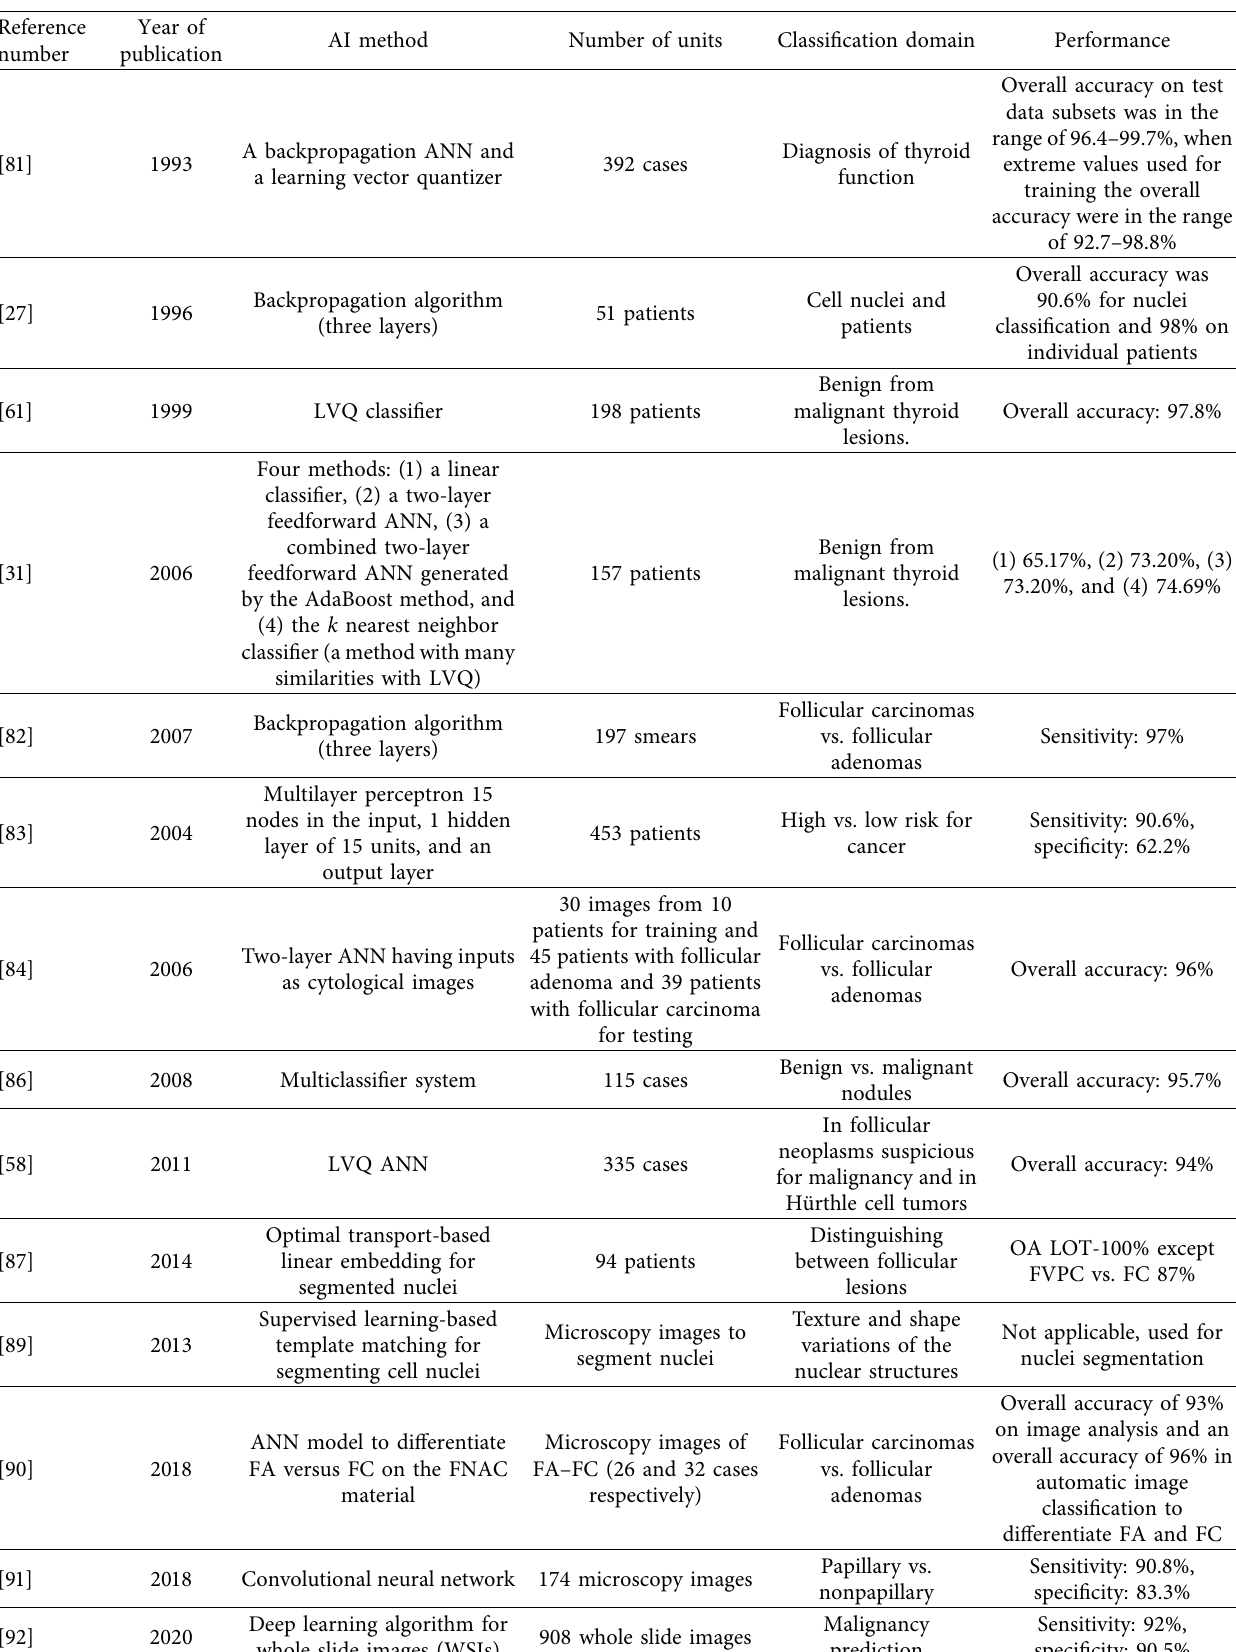
Table 8: Performance indices for the patient classification subsystems (numeric and percentage classifiers) for the training and test sets and for both sets